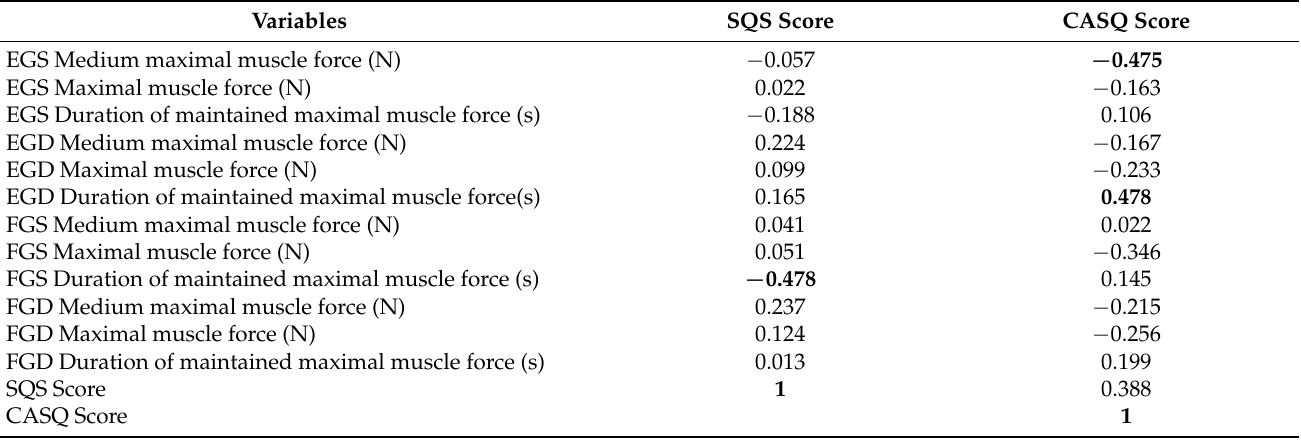
Table 17. Pearson correlation between SQS, CASQ scores and muscle parameters of left and right knee extensors and flexors.